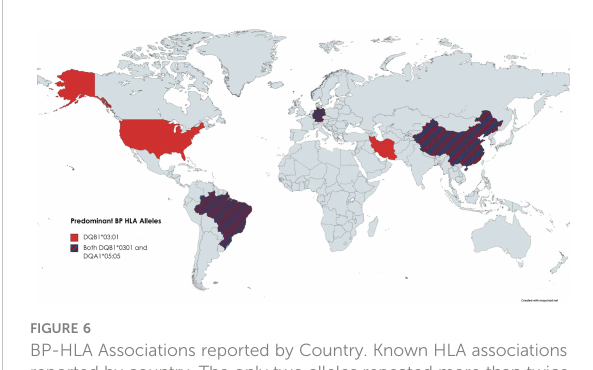
FIGURE 6 BP-HLA Associations reported by Country. Known HLA associations reported by country. The only two alleles repeated more than twice were DQB1*0301 and